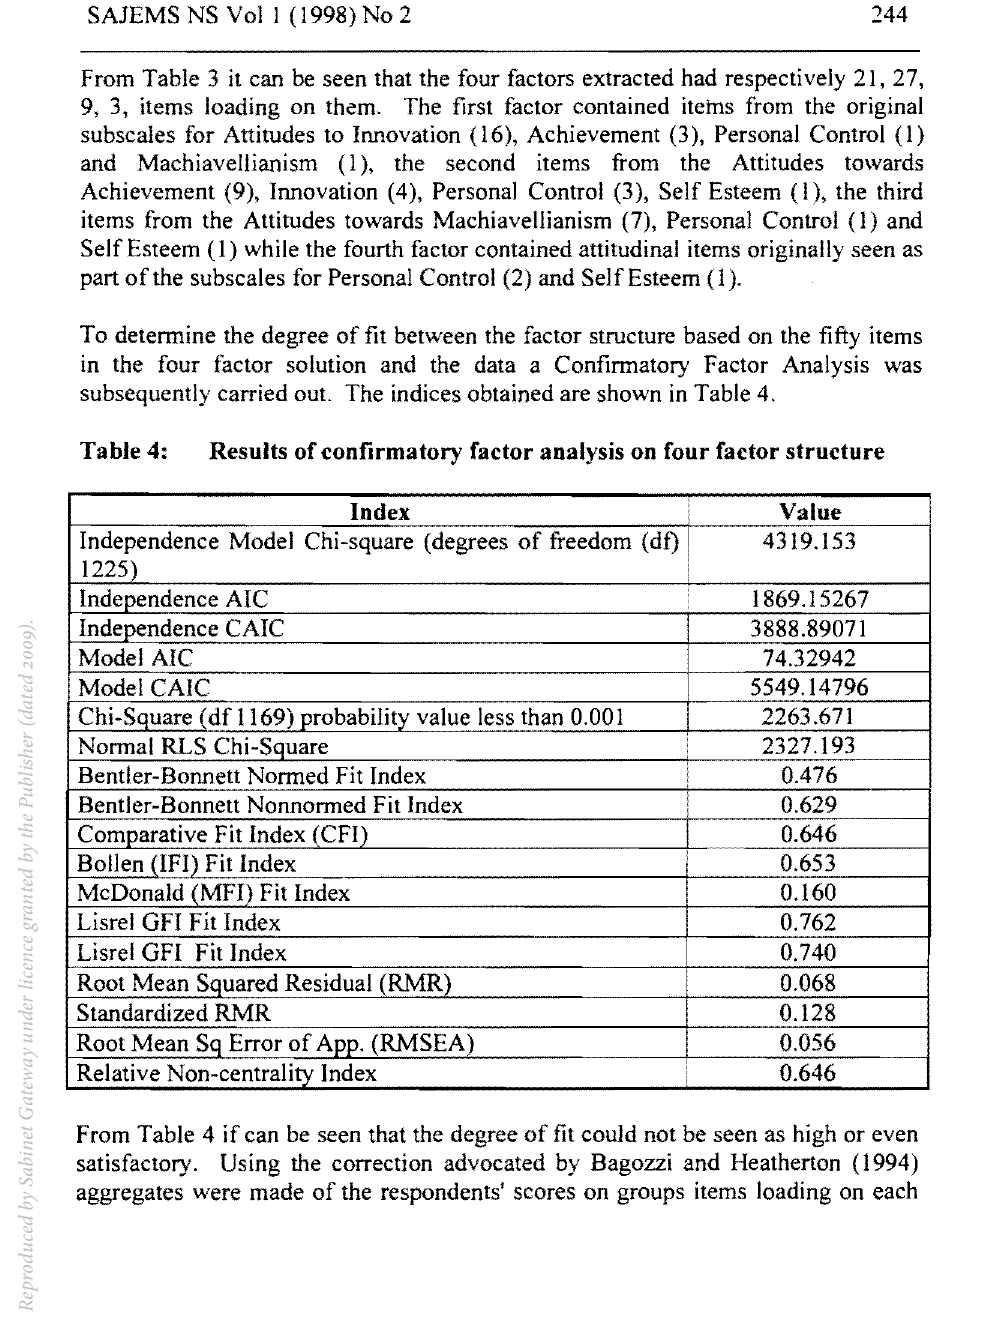
Results of confirmatory factor analysis on four factor structure Index